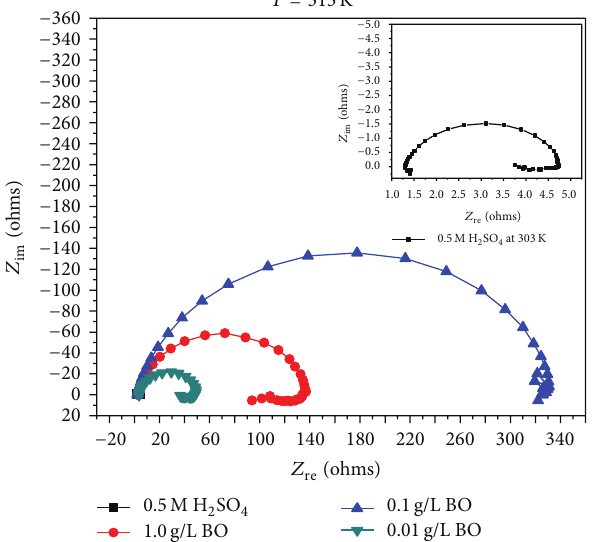
Figure 6: Nyquist plot for pipeline steel in 0.5 M H 2 SO 4 with and without different concentrations of Brassica oleracea extract at 313 K.